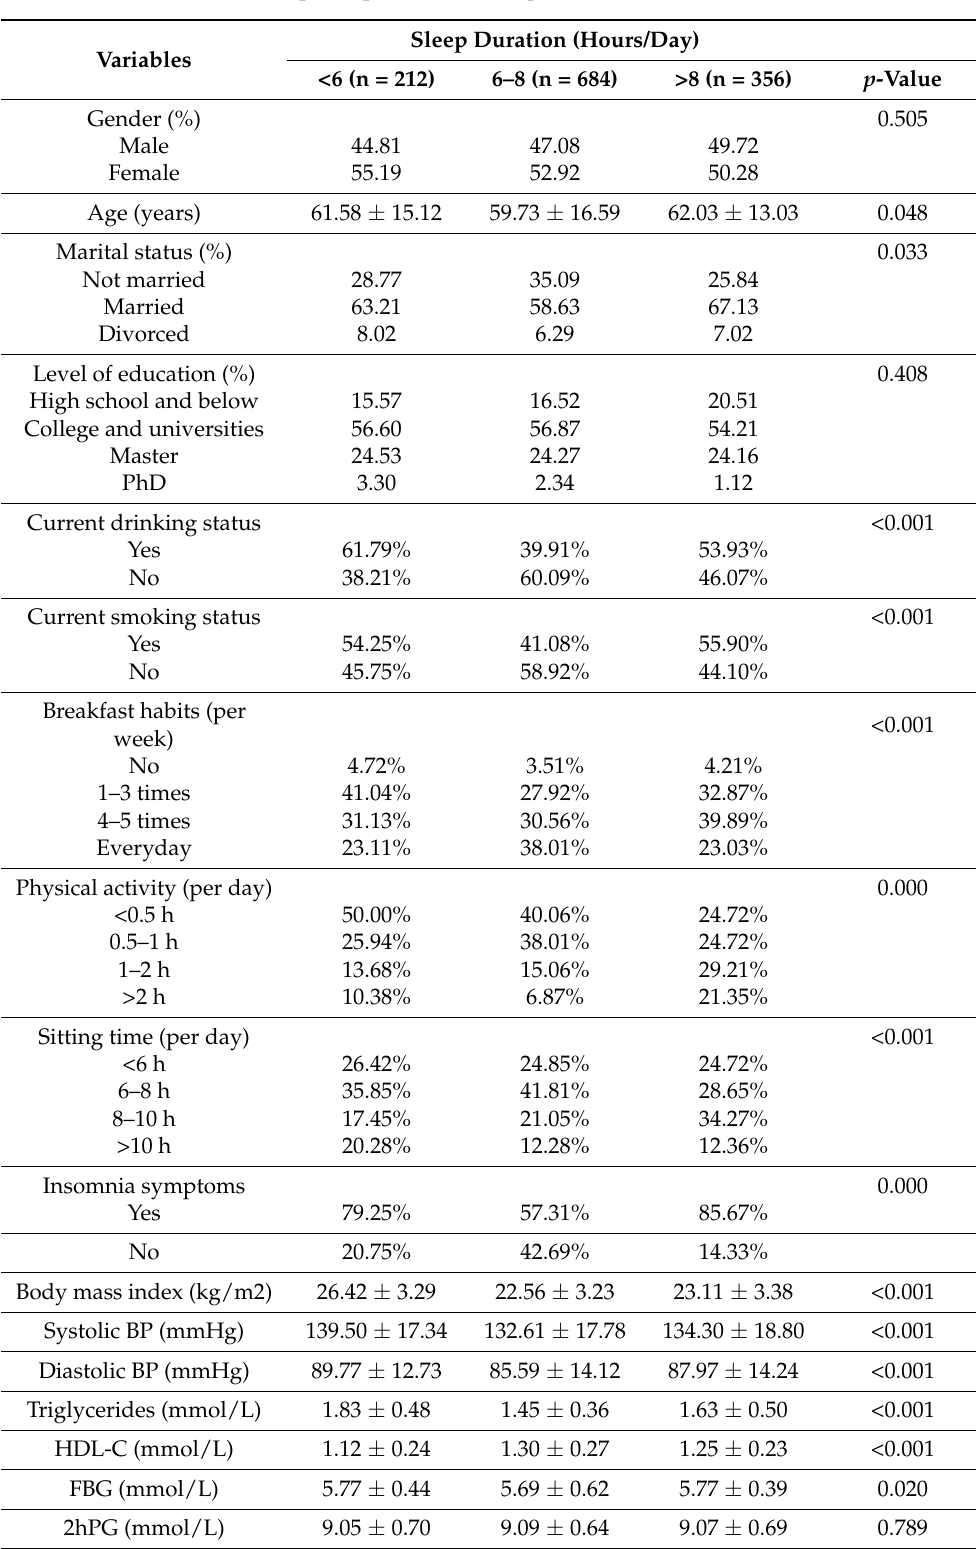
Table 1. Characteristics of the participants across sleep duration (N =